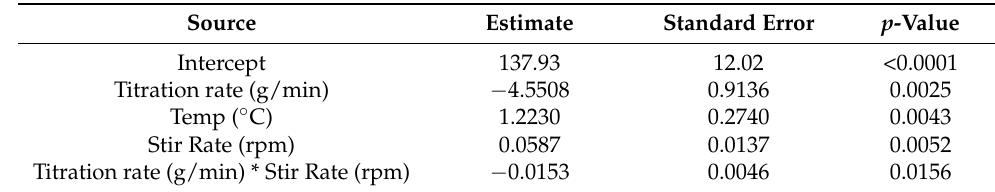
Table 3. Model parameters, estimates, standard error, and p -values for all terms included in the multiple linear regression model.